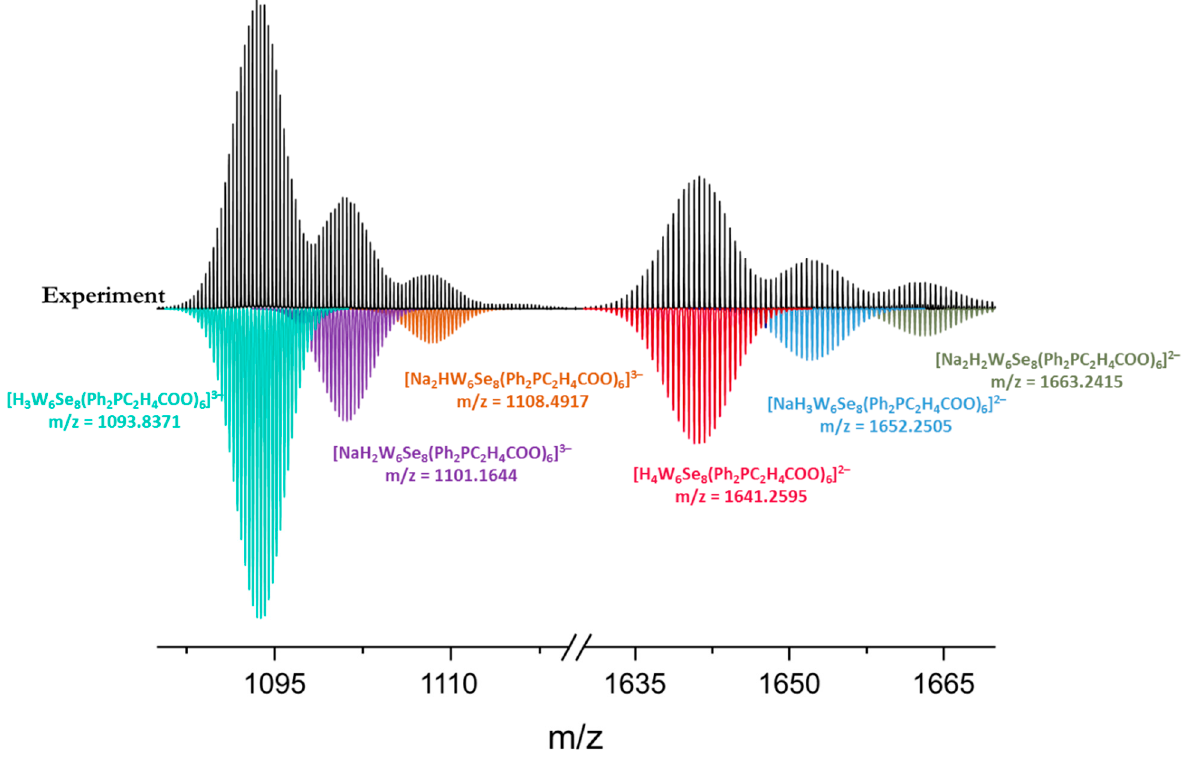
Figure 4. Fragments of the mass spectrum of Na 6 - 2 in aqueous solution (black) and simulated profiles of forms (colored).